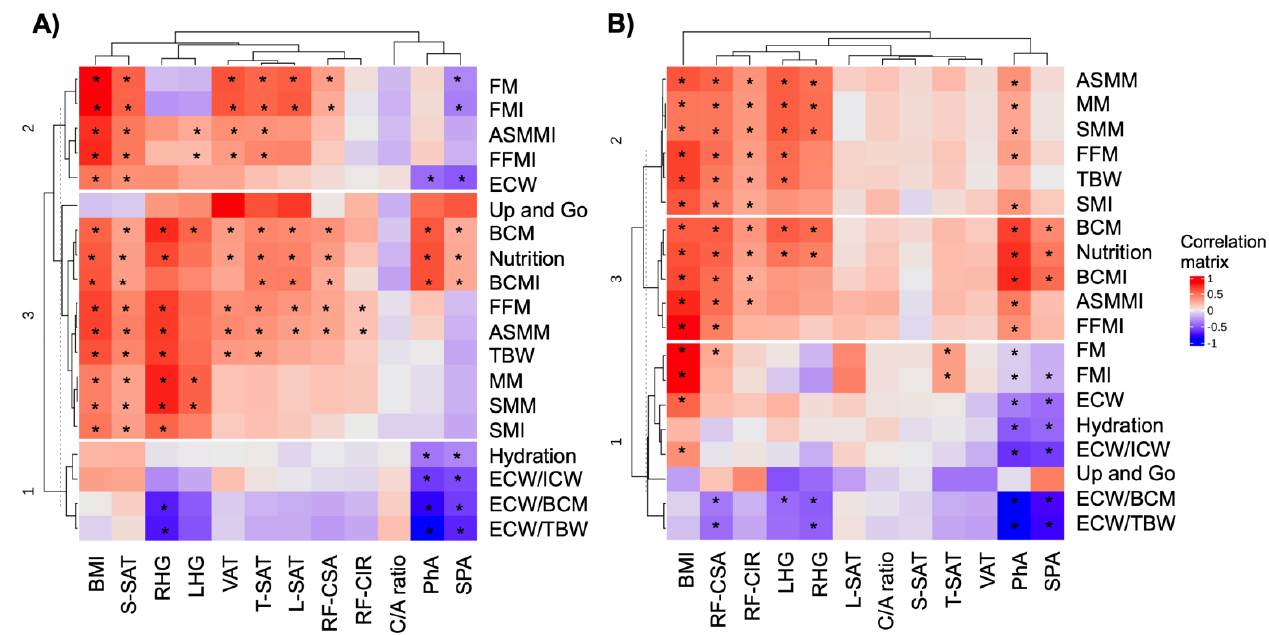
Figure 1. Correlation plots are presented to show association between body composition ( X -axis) and body measurements ( Y -axis) of ( A ) females and ( B ) males. A Pearson correlation coefficient test was conducted and the asterisk indicates significant correlation between variables according to the test (* p < 0.05). Abbreviations: BMI: body mass index; BIA: bioelectrical impedance analysis; CRP: